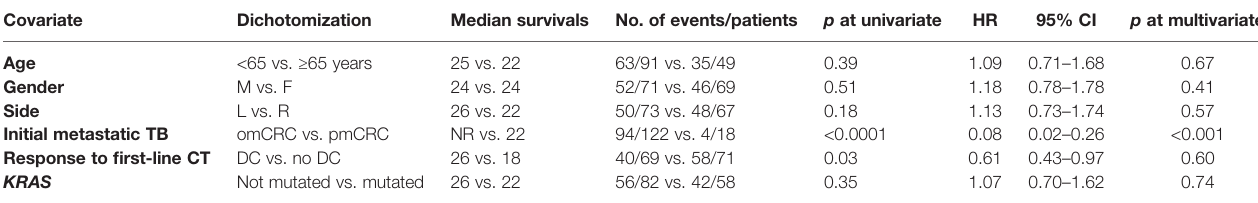
TABLE 2 | Multivariate analysis of clinical and molecular characteristics in the selected clinical cohort.